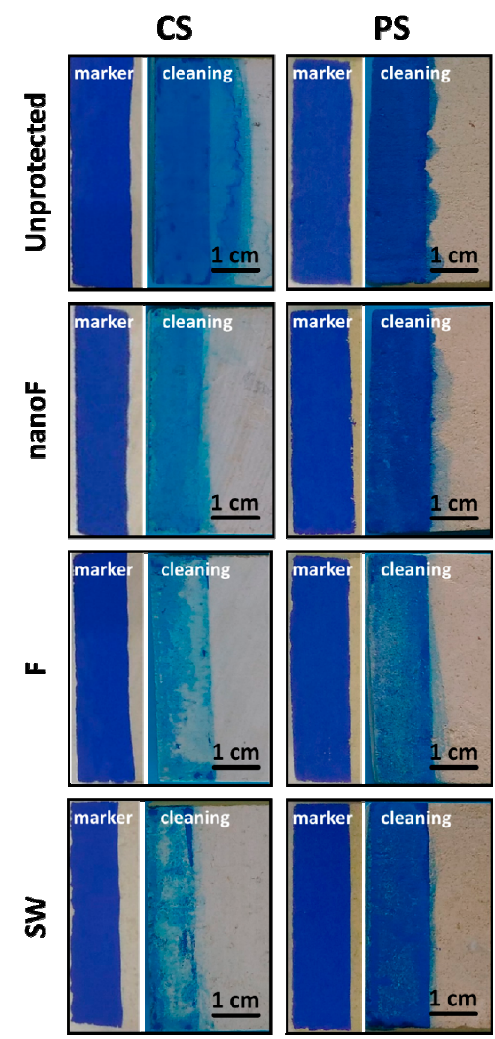
Figure 11. Protected and unprotected stone samples after the staining by felt-tip marker and after the cleaning procedure (CS = compact stone; PS = porous stone); the neat surface is on the right of each image.